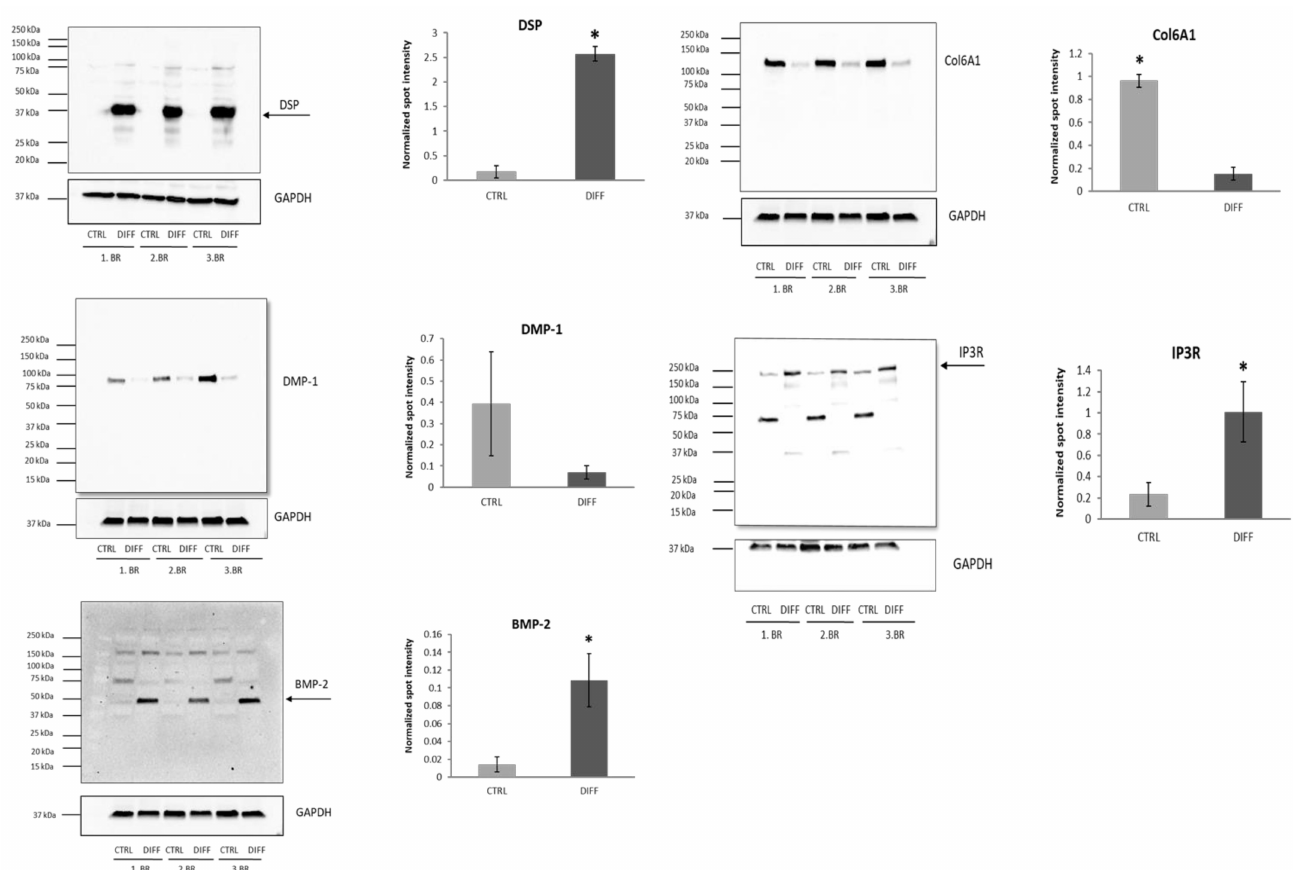
Figure 6. Confirmation of several differentially abundant proteins by Western blotting. Densitometric analysis of protein abundance was performed using ImageLab software. Values represent the means of three biological replicates. Error bars denote the standard deviations, * indicate p ≤ 0.05. Arrows indicate densitometrically analyzed major protein bands: DSP a likely cleavage product of DSPP, BMP-2 mature protein, and functional IP3R tetramer. Abbreviations: DSP (dentin sialoprotein), DMP-1 (dentin matrix protein 1), BMP-2 (bone morphogenetic protein 2), IP3R (inositol 1,4,5-trisphosphate receptor), Col6A1 (collagen 6 alpha 1 chain), GAPDH (glyceraldehyde 3-phosphate